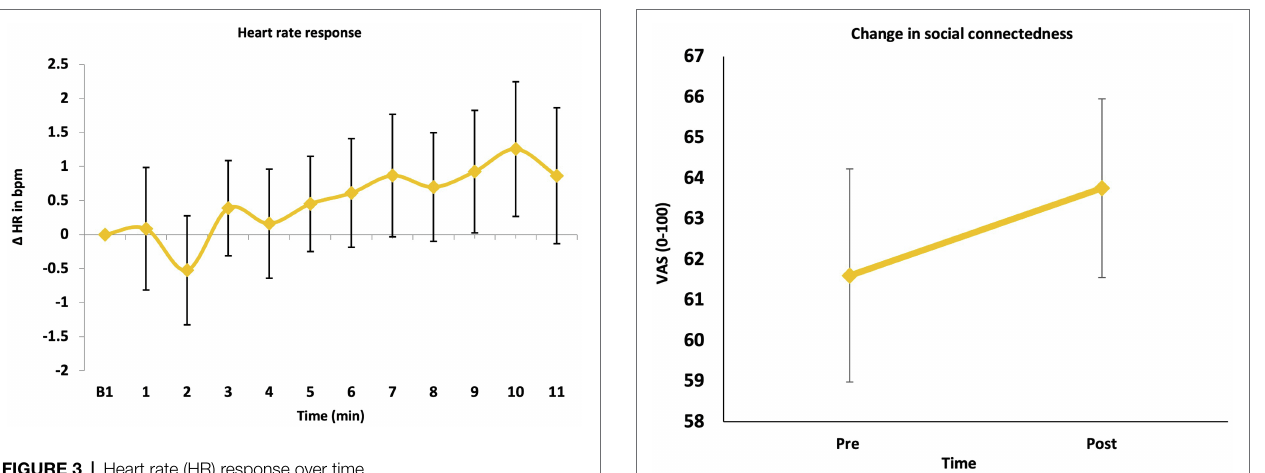
FIGURE 3 | Heart rate (HR) response over time.